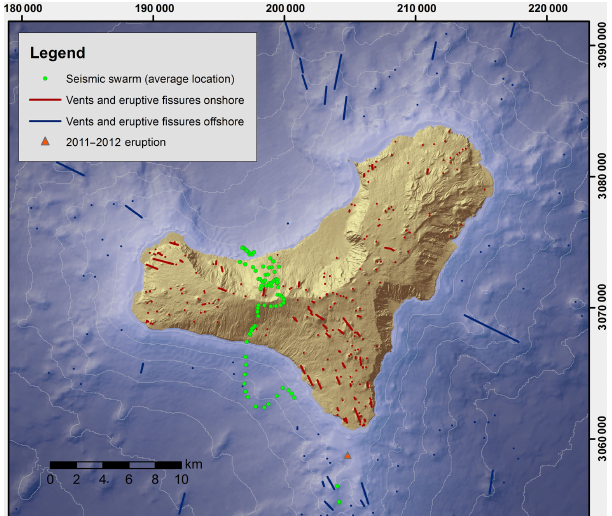
Figure 2. Structural data of El Hierro (vents and fissure onshore and offshore, as in Becerril et al., 2013, 2014) and the evolution of the seismicity during the unrest period (average location of the seismic